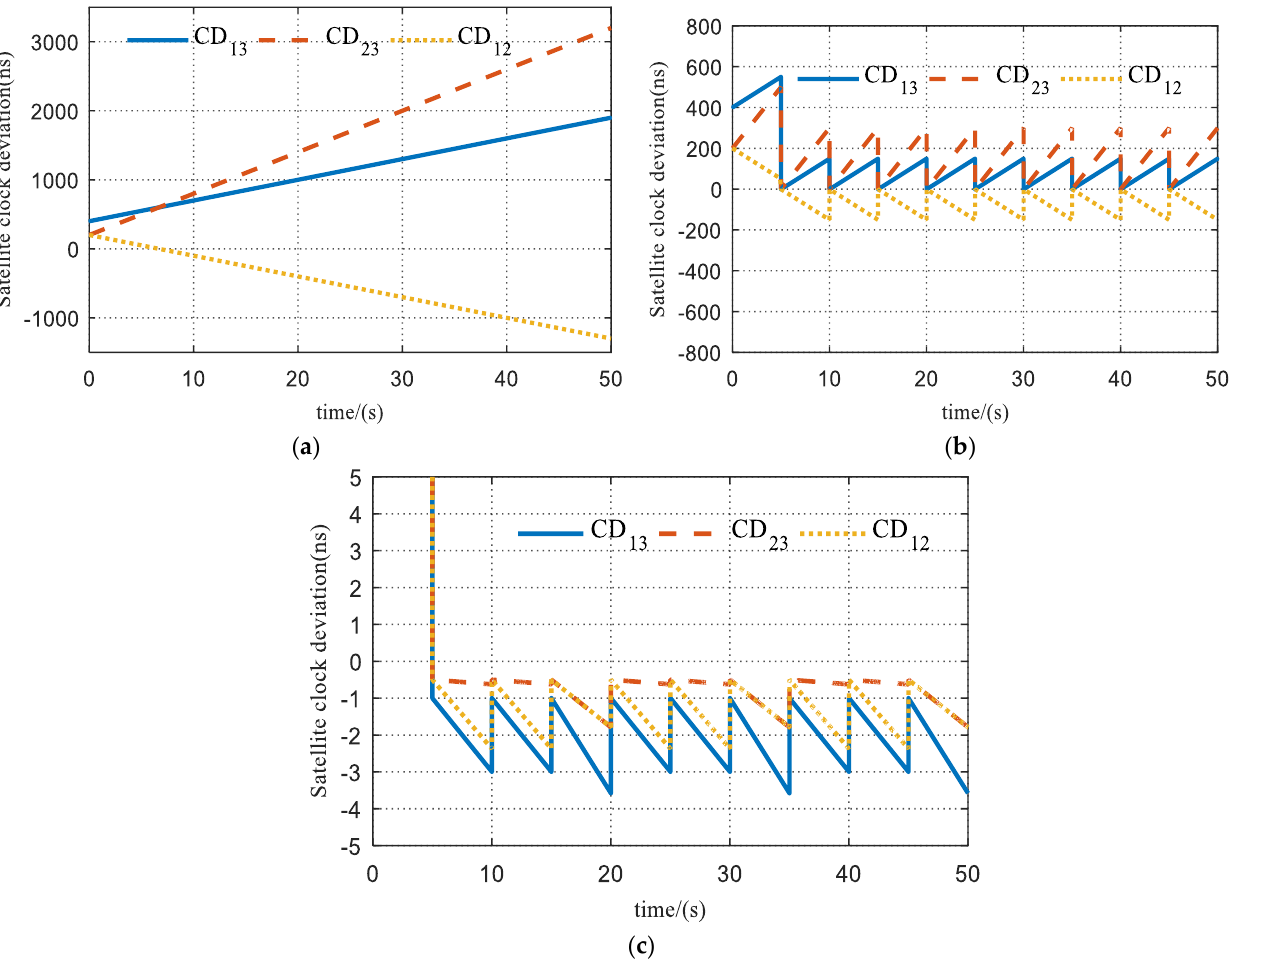
Figure 11. Simulation results of inter-satellite clock synchronization: ( a ) satellite clock deviation without synchronization; ( b ) satellite clock deviation with only phase correction; and ( c ) satellite clock deviation with both phase and frequency correction.